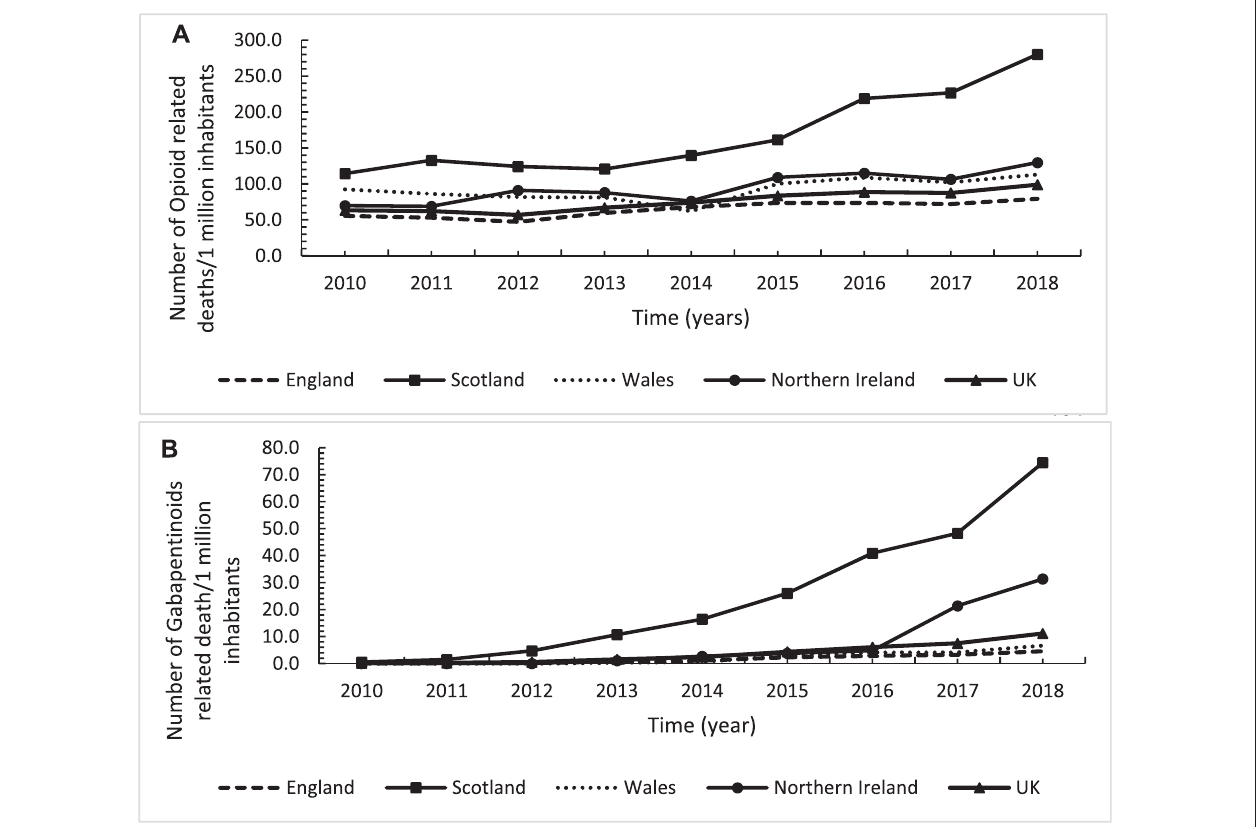
FIGURE 5 | Annual trends in number of deaths per one million inhabitants for opioids (A) and gabapentinoids (B) across the United Kingdom, England, Scotland, Wales and Northern Ireland over the study period from 2010 to 2018.